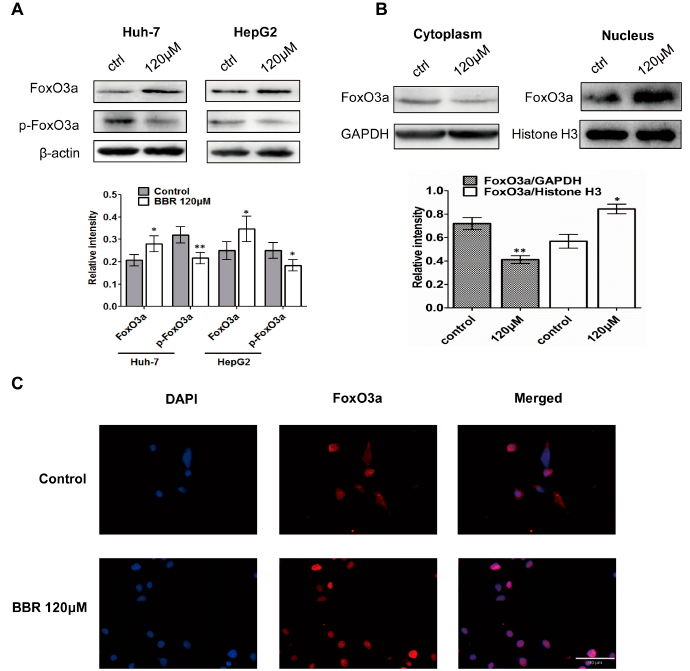
Figure 4. Effects of berberine treatment on FoxO3a and p-FoxO3a expression. ( A ) Huh-7 and HepG2 cells were treated with DMSO or 120 μ M berberine for 24 h. Western blot was used to detect changes in the FoxO3a and p-FoxO3a; ( B ) FoxO3a in cytoplasm and nucleus of Huh-7 cells were detected by western blot and normalized by GAPDH and Histone H3 respectively. Relative expression levels are shown in the following bar graph where ** represents p < 0.01 and * represents p < 0.05 (120 μ M group vs. control group.) The experiments were carried out for three times; ( C ) The induction effect of berberine on the nuclear translocation of FoxO3a in Huh-7 cells. Immunofluorescence images stained for anti-FoxO3a (1:100) and DAPI; ** represents p < 0.01 and * represents p < 0.05 (other experimental groups vs. control group). Scale bar = 90 µ